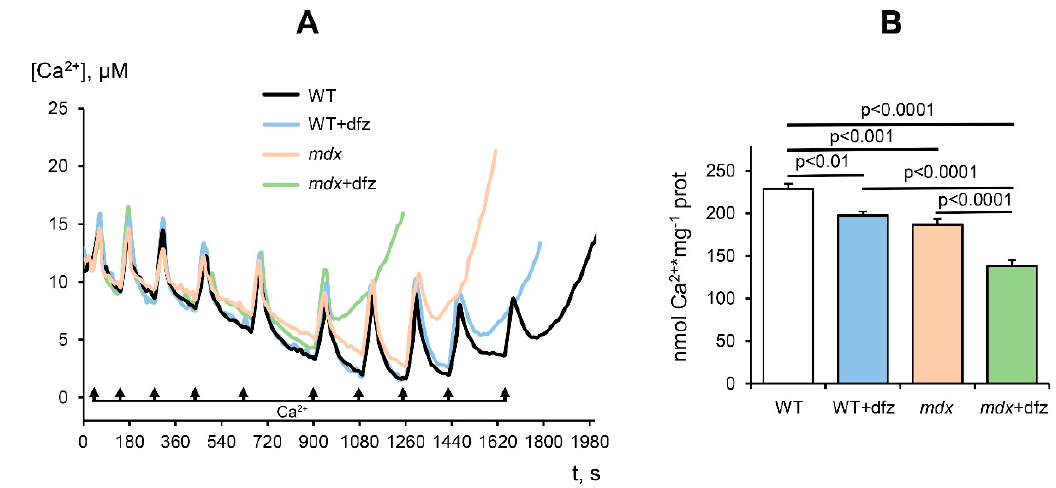
Figure 7. Induction of the Ca 2 + -dependent MPT pore in the skeletal-muscle mitochondria of the studied groups of mice. Uptake of sequential Ca 2 + additions by the skeletal-muscle mitochondria ( A ). Incubation medium: 210 mM mannitol, 70 mM sucrose, 2.5 mM glutamate, 1 mM KH 2 PO 4 , 50 µ M arsenazo III, 10 µ M EGTA, 2.5 mM malate, 10 mM Hepes / KOH (pH 7.4). Additions: skeletal-muscle mitochondria (0.45 mg / mL), 10 µ M CaCl 2 . The figure shows traces of a typical experiment conducted at the same time on the same mitochondrial preparation. Similar results were obtained in five independent experiments. Ca 2 + capacity of the skeletal-muscle mitochondria of studied groups of mice ( B ). The data are presented as means ± SEM ( n = 5).